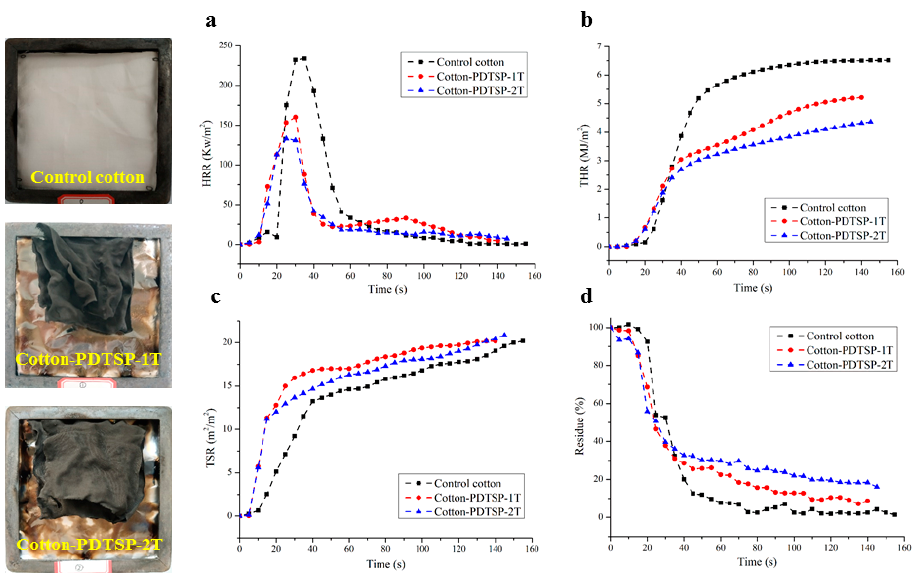
Figure 8. HRR ( a ), THR ( b ), Residue ( c ) and TSR ( d ) curves for Control cotton, Cotton-PDTSP-1T and Cotton-PDTSP-2T. Table 4. Cone calorimetry data for control cotton and PDTSP-coated cotton fabrics.